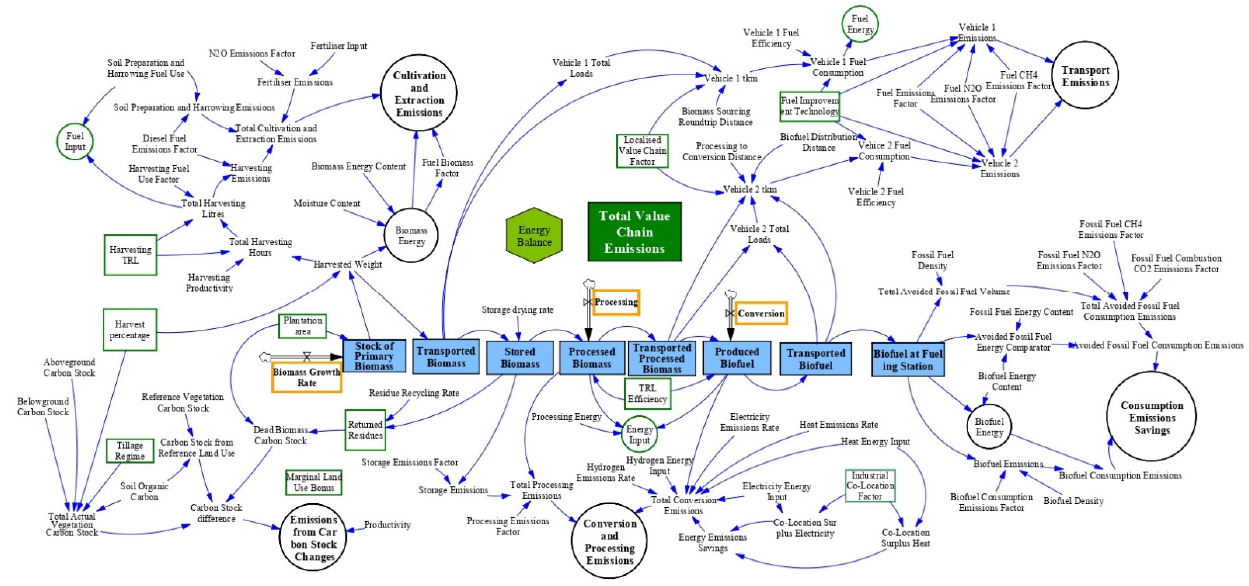
Figure 2. System dynamics model of an advanced biofuel value chain and performance indicator pathways.